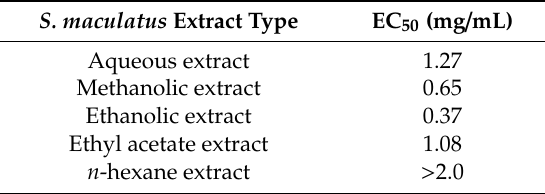
Table 2. The half-maximal e ff ective concentration (EC 50 ) values of the radical scavenging activity of five S. maculatus extracts: aqueous, methanolic, ethanolic, ethyl acetate, and n -hexane ( n = 4).